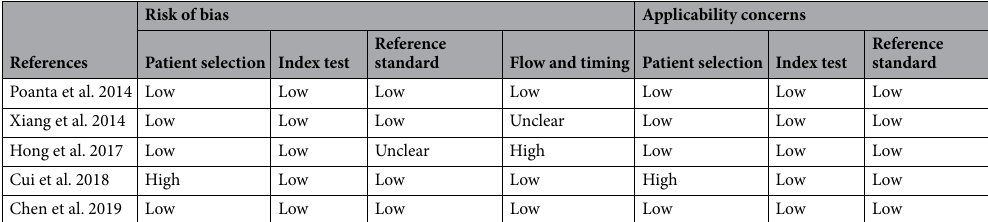
Table 3. Assessment of the risk of bias of the included studies. Presented are the assessed risks of bias and concerns regarding applicability of the studies following QUADAS-2 7 procedure. The indications obtain the degree of risk and the concerns of applicability,